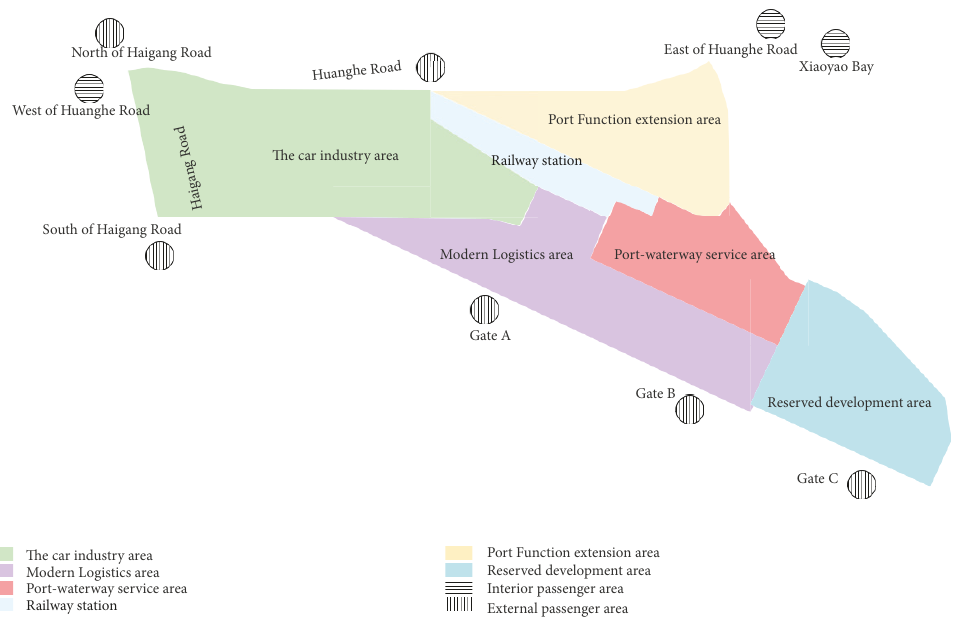
Figure 12: Different functional regions in